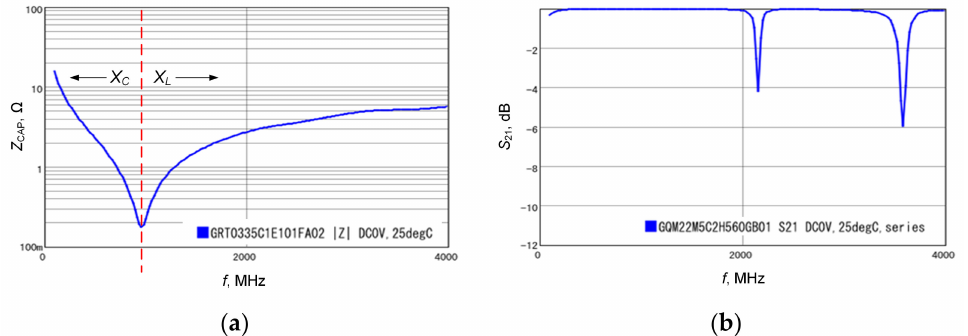
Figure A2. Characteristics of 100 pF capacitor—example: ( a ) Impedance Z CAP ; ( b ) S 21